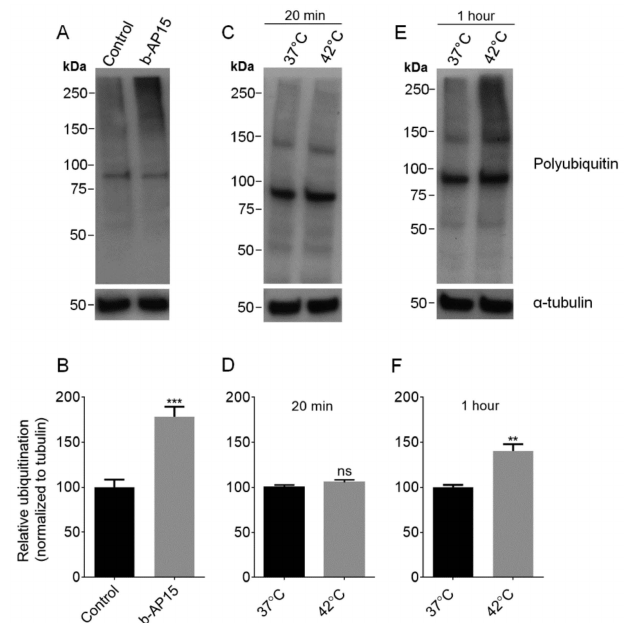
Figure 1. Analysis of the e ff ect of b-AP15 and heat shock on the ubiquitination of proteins, using anti-ubiquitin antibody. Top panels: representative Western blots for ubiquitination and α -tubulin (as loading control) in HEK 293T cells after various treatments. Lower panels: the broad “smear” of ubiquitinated proteins from 50 kDa to the top of the gel was quantified using ImageJ and normalized to α -tubulin. Treatments: 1 µ M b-AP15 in 0.05% DMSO for 1 h or control (0.05% DMSO alone) for 1 h ( A , B ); heat shock at 42 or 37 ◦ C control for 20 min ( C , D ); heat shock at 42 or 37 ◦ C control for 1 h ( E , F ). Error bars represent the standard error of mean ( n = 6). ***, p ≤ 0.001 and **, p ≤ 0.01 using Student’s t -test; ns: not significant.